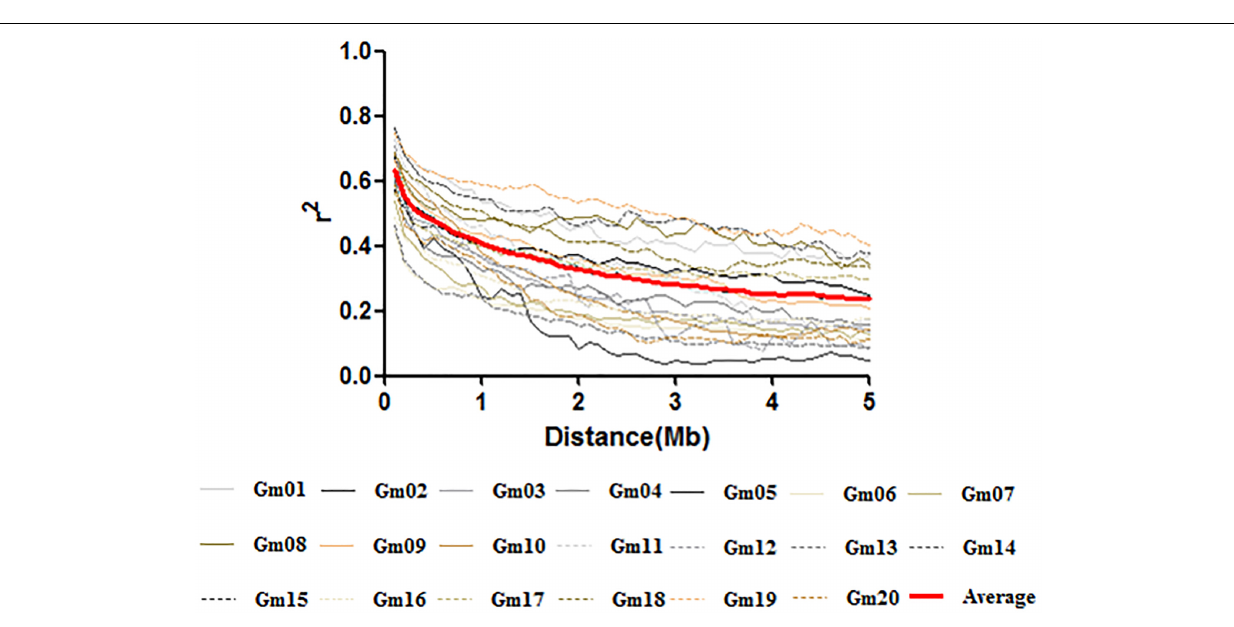
of GIGANTEA (GI) gene (Watanabe et al., 2011). This gene is located 338 kb downstream from Gm10_44378814 ( Supplementary Table 4 ). A total of 275 Arabidopsis homologs